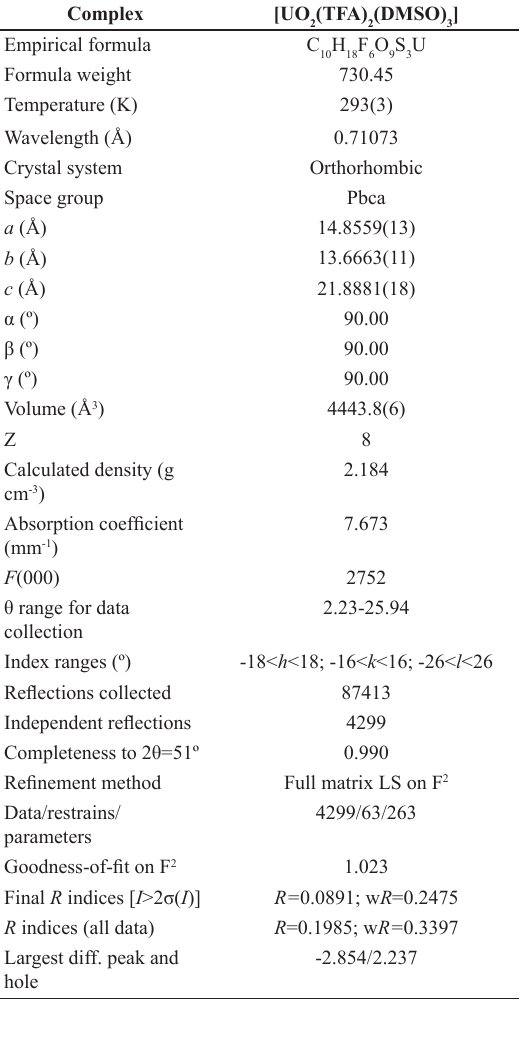
Table 1. Crystal data and structure refinement for [UO complex.